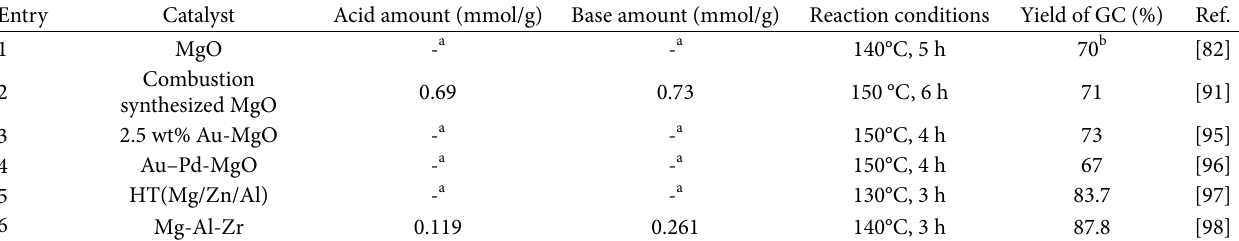
Scheme 8: Proposed mechanism for GC production from glycerol and urea using HT. Table 2: Catalytic glycerolysis of urea to GC using magnesium-based